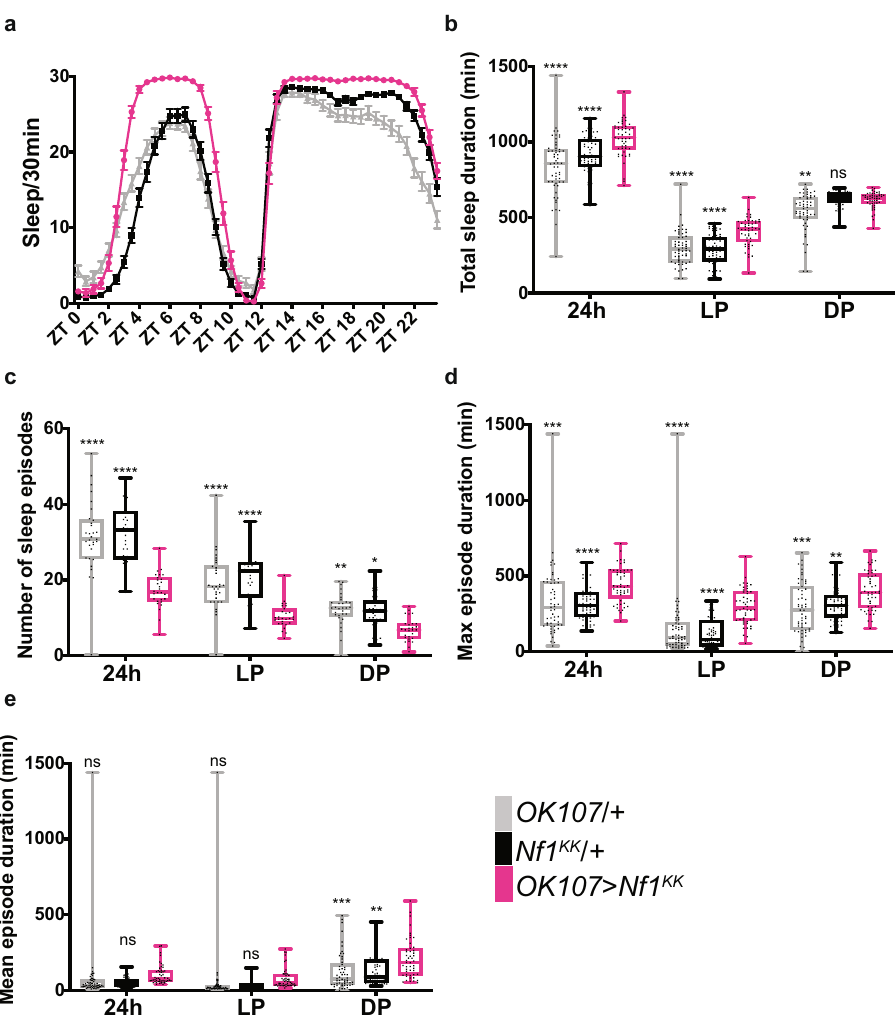
Fig. 4 NF1 in the MB promotes daytime wakefulness. a Sleep pro fi les of OK107 > Nf1 KK , GAL4-only control ( OK107 / + ) and UAS-only control ( Nf1 KK / + ) fl ies per 30-min bin averaged over 5 days during LD (n = 49-59 per group). Values represent the mean ± SEM. b – e Different sleep variables were analyzed over a 24 h period, during the light phase (LP) and during the dark phase (DP). The center lines of the boxplots indicate the median, box boundaries are 25th and 75th percentiles, and the whiskers represent the minimum and maximum values. Values of OK107 > Nf1 KK were compared with those of OK107 / + and Nf1 KK / + using the two-way ANOVA with Dunnett ’ s multiple comparisons test (* p < 0.05, ** p < 0.01, *** p < 0.001, and **** p < 0.0001). b Total sleep duration. c Number of sleep episodes. d Maximum sleep episode duration. e Mean sleep episode duration. Source data are provided as a Source Data fi